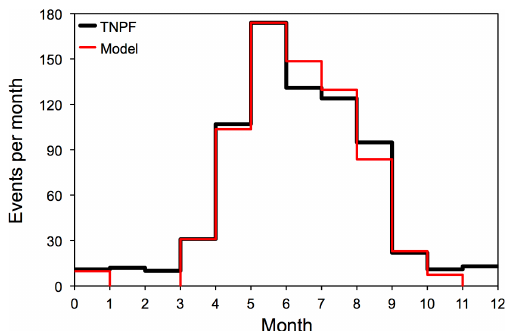
Figure 10. Average monthly sums of NPF events due to the three types of new particle formation (TNPF; black), summed up over the whole period of 10 years. Red: three-parameter model to describe TNPF.